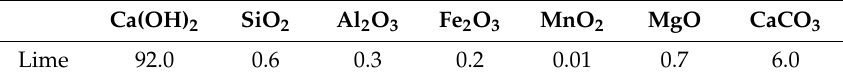
Table 3. Chemical composition of lime, wt % (by X-ray